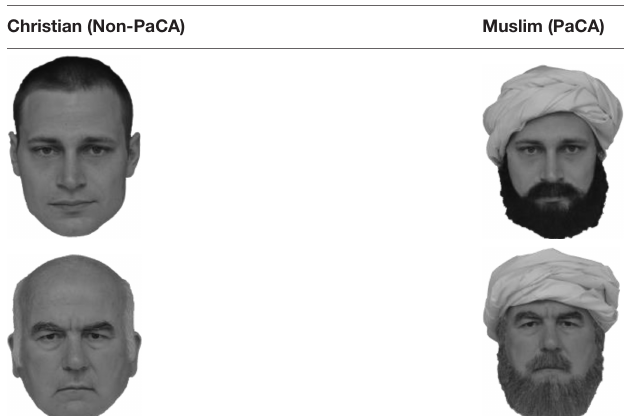
TABLE 2 | Exemplary faces (plain and modified with paraphernalia) used in the md-IAT (Study 1 and